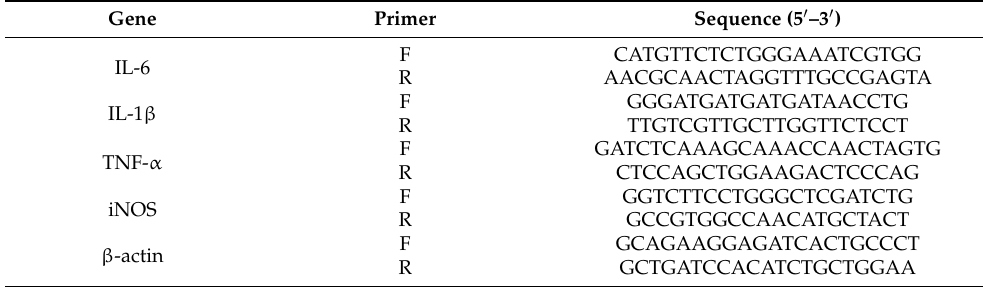
Table 4. List of primers. F represents forward primer and R represents reverse primer. Gene Primer Sequence (5 (cid:48) –3 (cid:48)